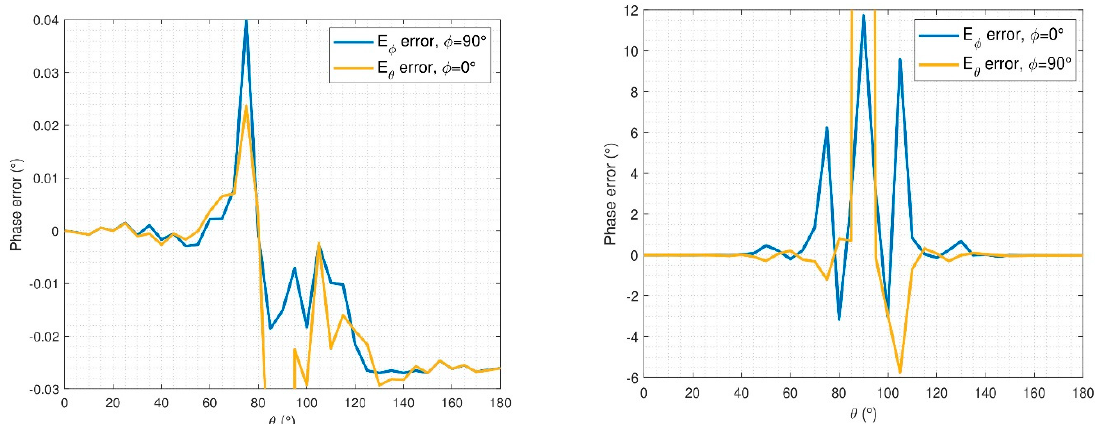
Figure 10. Near ‐ field (NF) retrieved phase error for E θ and E φ . Figure 10. Near-field (NF) retrieved phase error for E